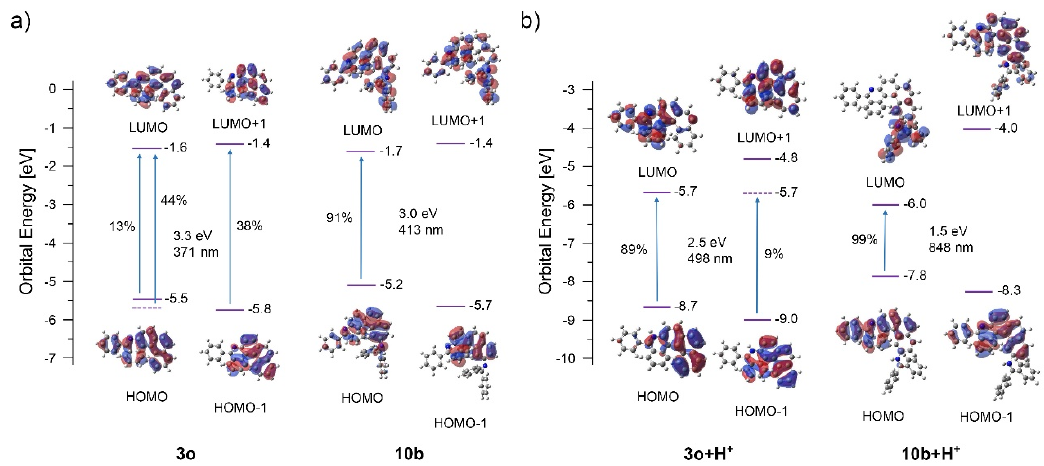
Figure 6. Orbital energies, excitation wavelengths, and dominating orbital contributions to the excited states of neutral ( a ) and protonated versions ( b ) of reactants 3o and 10b .